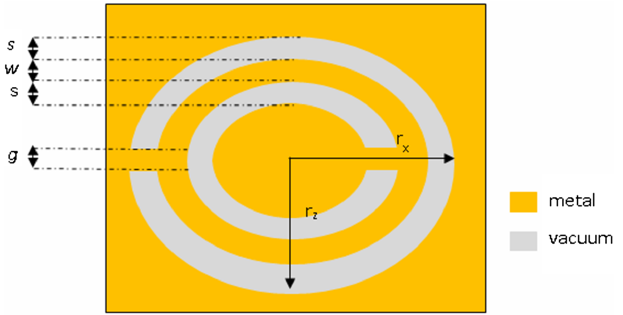
FIG. 1. Top view of the elliptical